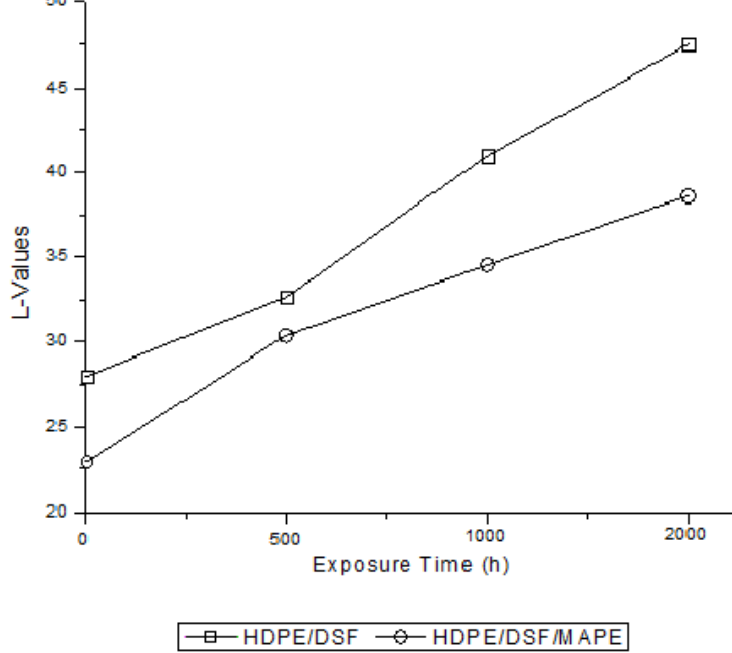
Figure 6: Effect of exposure time on L of HDPE/DSF and HDPE/DSF/MAOE